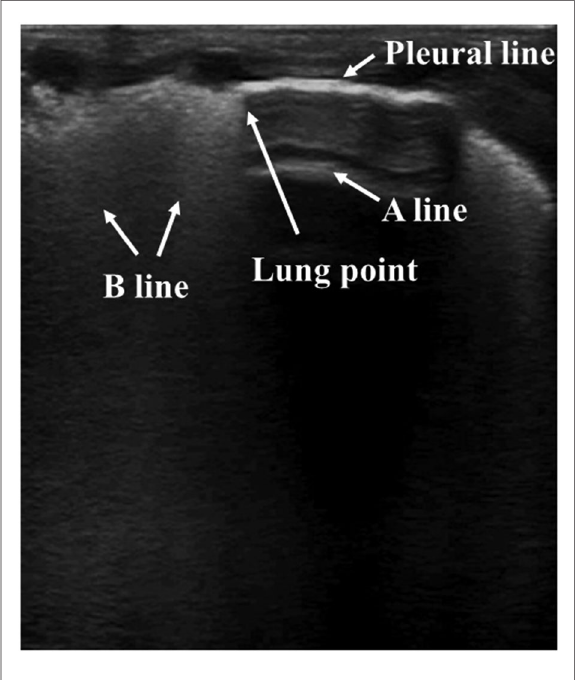
FIGURE 6 Pneumothorax on lung ultrasonography. Lung point: the transition from the B-lines area (left side) to a hypoechoic area (right